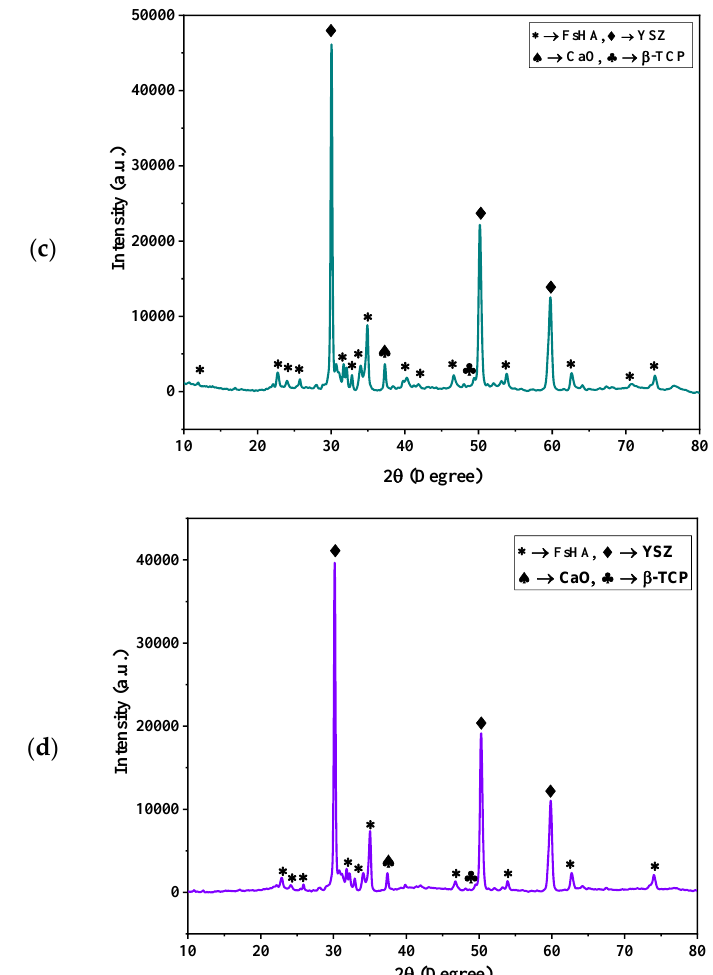
Figure 8. XRD patterns of plasma-sprayed FsHA with (a) 0 wt.% YSZ, (b) 10 wt.% YSZ, (c) 15 wt.% YSZ, and (d) 20 wt.% YSZ coatings.